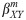
The different mechanisms underlying (A) the associations between maternal phenotypes and pregnancy outcomes and (B) the associations between pregnancy outcomes and late adult phenotypes in offspring. These mechanisms include 1) causal effects of maternal phenotypes on pregnancy outcomes (βXYm) and causal effects of pregnancy outcomes on adult phenotypes (βYX′f) (green arrows), 2) genetically confounded associations between maternal phenotypes and pregnancy outcomes (βXYc) because of genetic sharing between mothers and infants and genetically confounded associations between birth outcomes and adult phenotypes in offspring (βYX′c) because of shared genetic effects (blue dashed arrows), 3) confounding due to environmental effects (gray dashed arrows, which were not examined in this study), and 4) fetal drive (βYXf)—fetus causally influencing maternal phenotypes during pregnancy (red arrow).